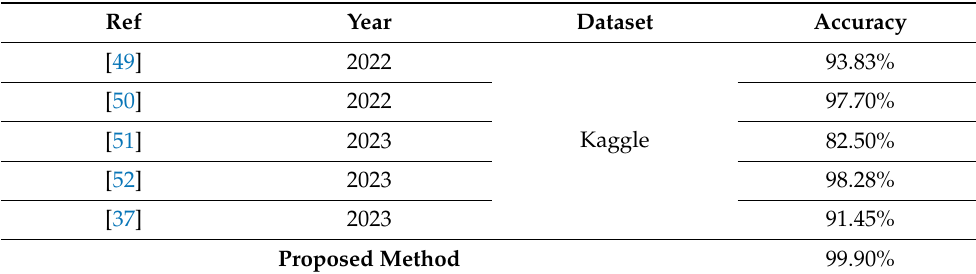
Table 9. Comparison of results.